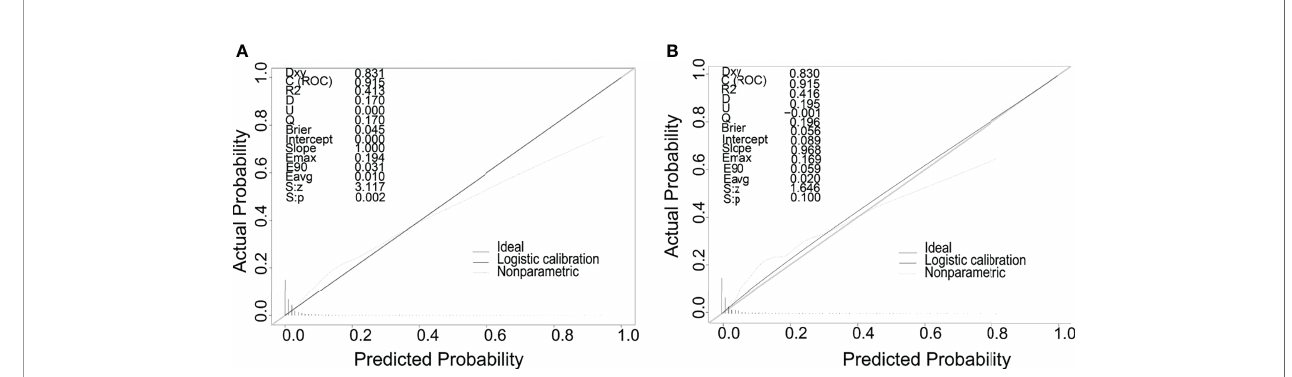
FIGURE 3 | Calibration curves of the nomogram for predicting LMs in patients with RCC in the training cohort (A) and the validation cohort (B) . The x-axis represents the nomogram-predicted probability of LMs; the y-axis represents the actual probability of